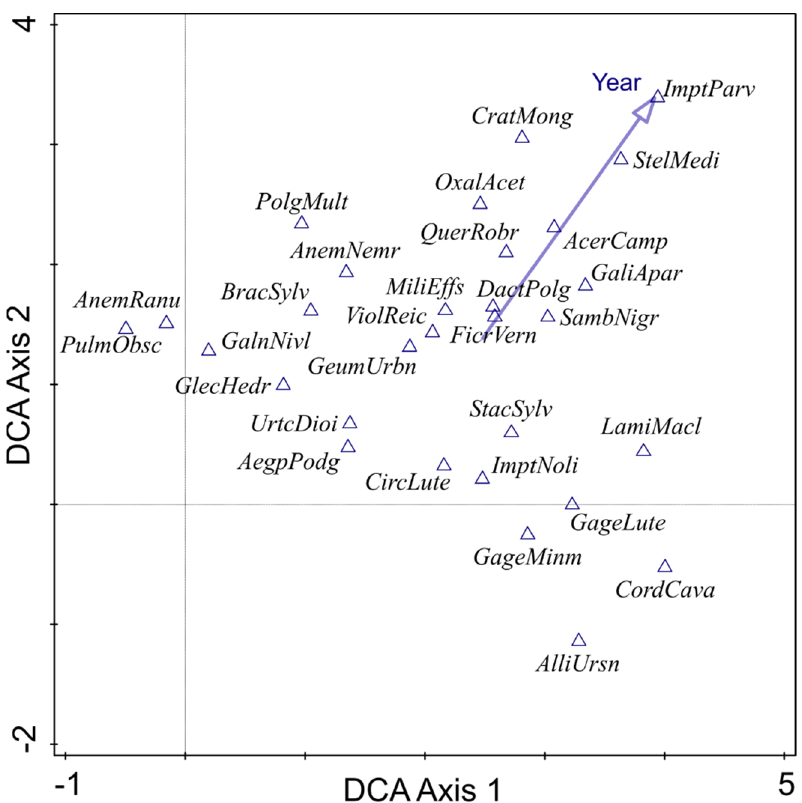
Figure 4. Results of the DCA summarized the variation of understory species composition of the protected, ancient riparian forests in the Odra Valley near O ł awa (Silesian Lowland, Southwestern Poland), surveyed in 1960, and resurveyed in 1990 and 2020, and with passive projection of the vector of Year as supplementary variable. Species with scores limit to 30 by fit according to total species composition. Explanation of the abbreviations used: AcerCamp— Acer campestre ;